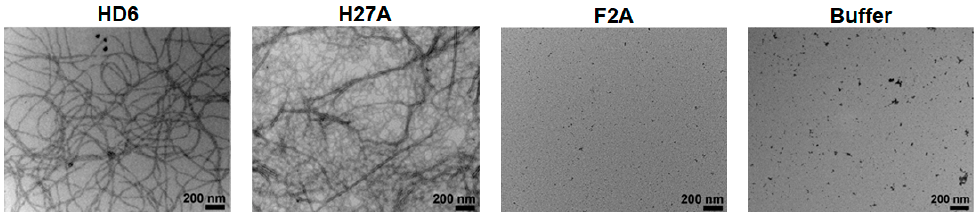
Figure 5. TEM micrographs of wild type HD6 and synthesized amino acid mutant nanonet formations in buffer. Scale bar = 200 nm. Adapted with permission from [101]. Copyright 2014 American Chemical Society.